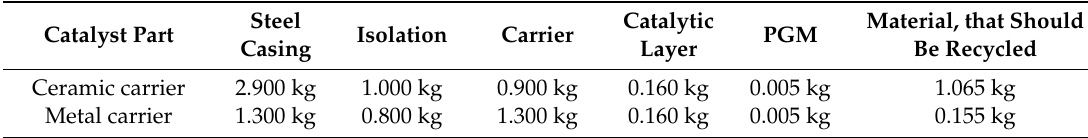
Table 2. Material composition of the typical auto catalyst [17].